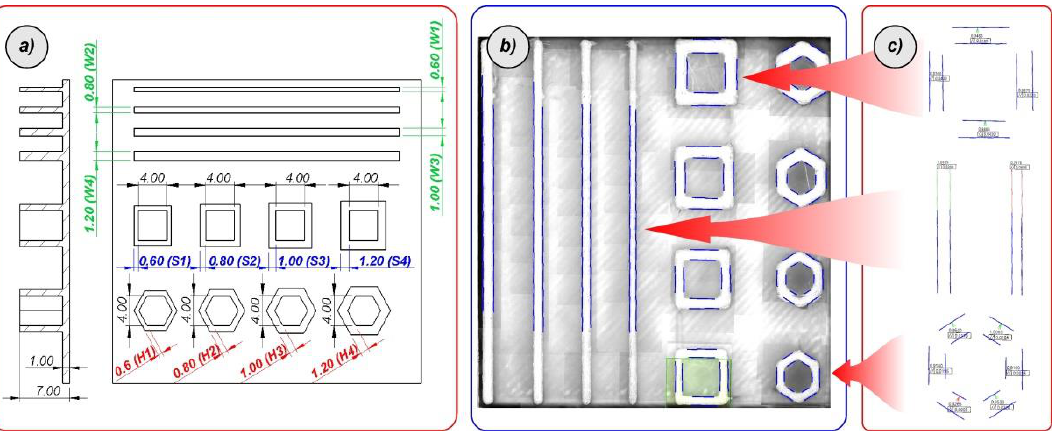
Figure 5. The process of optimisation the 3D printing parameters: ( a ) Developed benchmark model, ( b ) conducted measurements, ( c ) defined report with dimensional deviations.